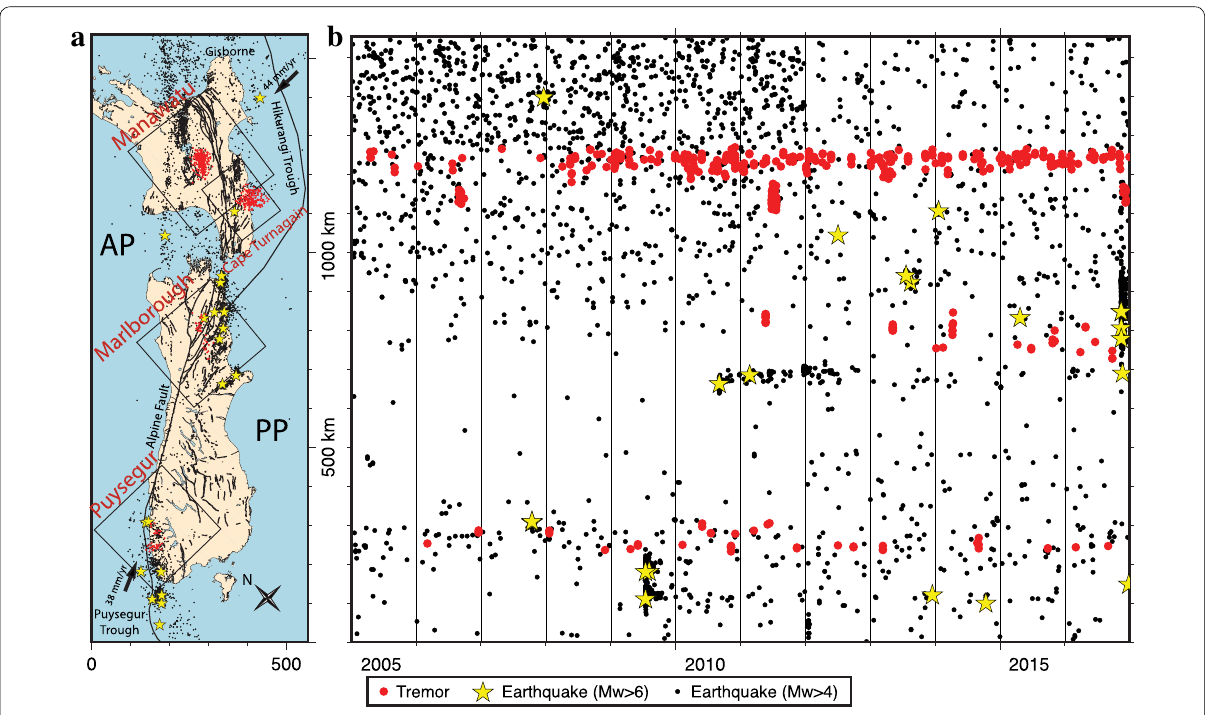
Fig. 1 a Map of the detected tremors in New Zealand. The four rectangular frames indicate the study regions. The fault lineations are from Langridge et al. (2016). The plate boundaries are taken from Bird (2003), and the plate velocities are from the MORVEL model (DeMets et al. 2010). AP Australian Plate, PP Pacific Plate. b Space–time projection of the detected earthquakes and